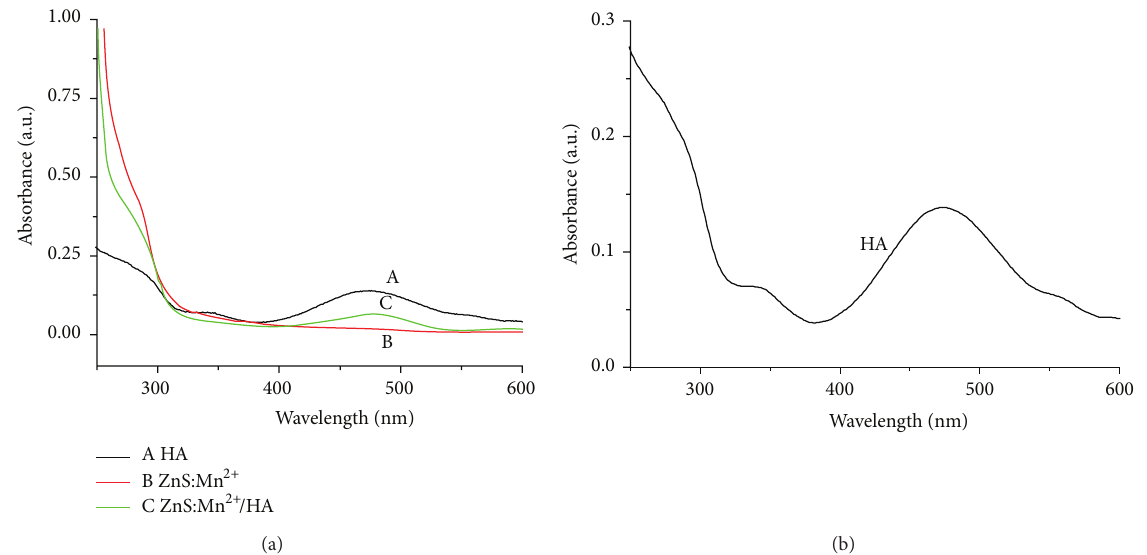
Figure 8: (a) Absorption spectra of HA (A), ZnS:Mn 2+ QDs (B), and HA-ZnS:Mn 2+ QDs system (C); (b) an image of absorption spectra of HA.